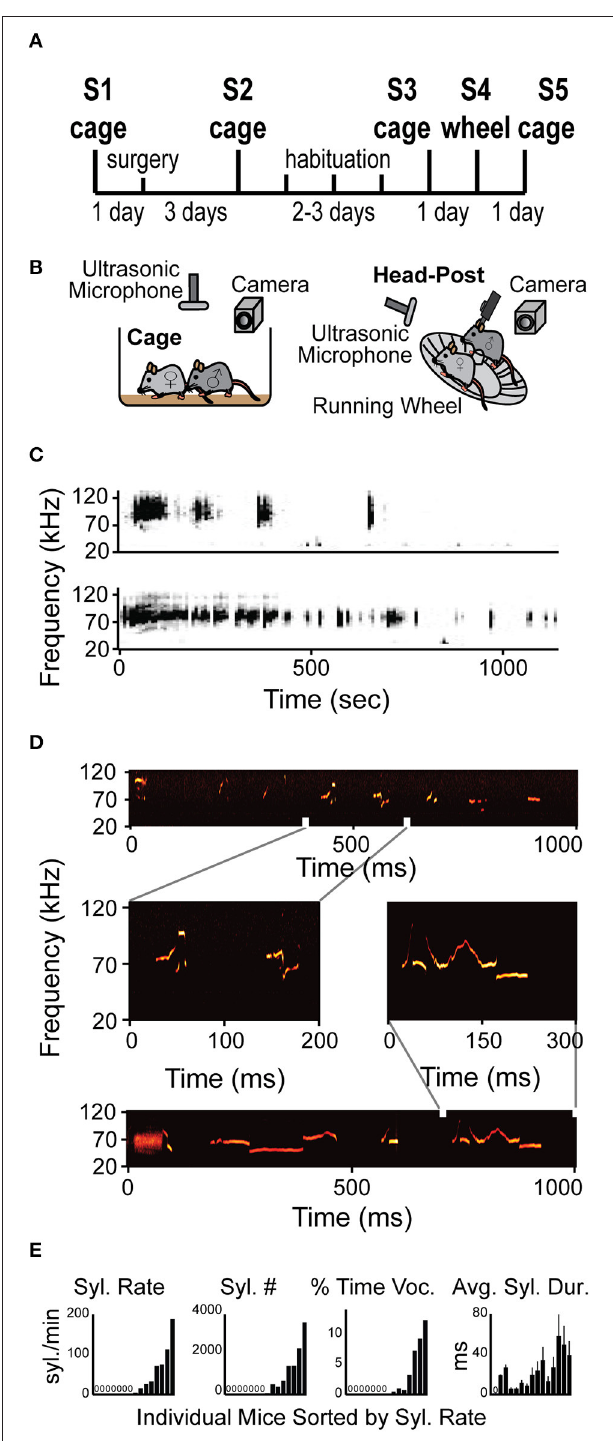
FIGURE 1 | Mice vocalize when head-fixed. (A) Diagram of the experimental design. The protocol included recordings in arena (cage) and one session recording head-fixed (wheel) (See Section Materials and Methods for details). (B) Schematic illustration of the experimental apparatus while non-restrained (cage) and head-restrained (head-post). Male is head-fixed while female is freely moving on the running wheel. (C) Representative